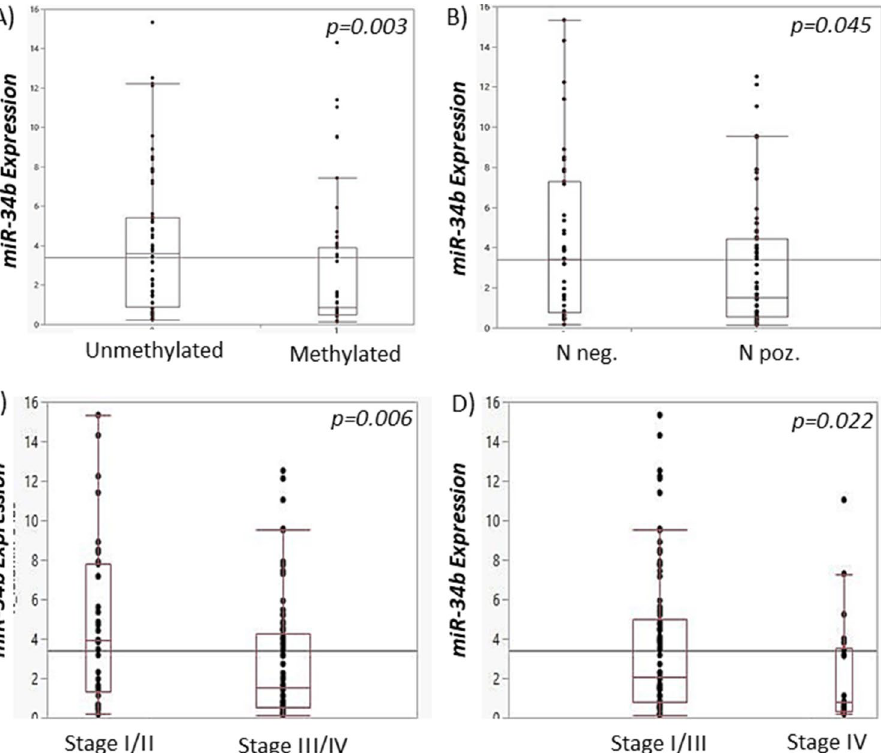
Figure 2. miR-34b/c methylation and miR-34b expression in the MMA hospital cohort ( A ) Association of miR- 34b/c methylation and miR-34b expression ( B ) miR-34b expression and nodal status ( C ) miR-34b expression in stage III/IV compared to stage I/II tumors ( D ) miR-34b expression in stage IV compared to stage I–III